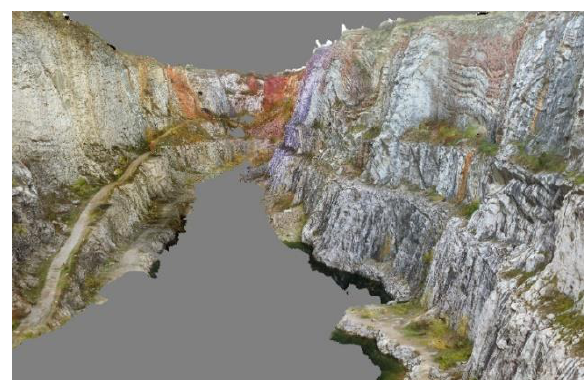
Figure 14. Part of 3D textured model of quarry’s